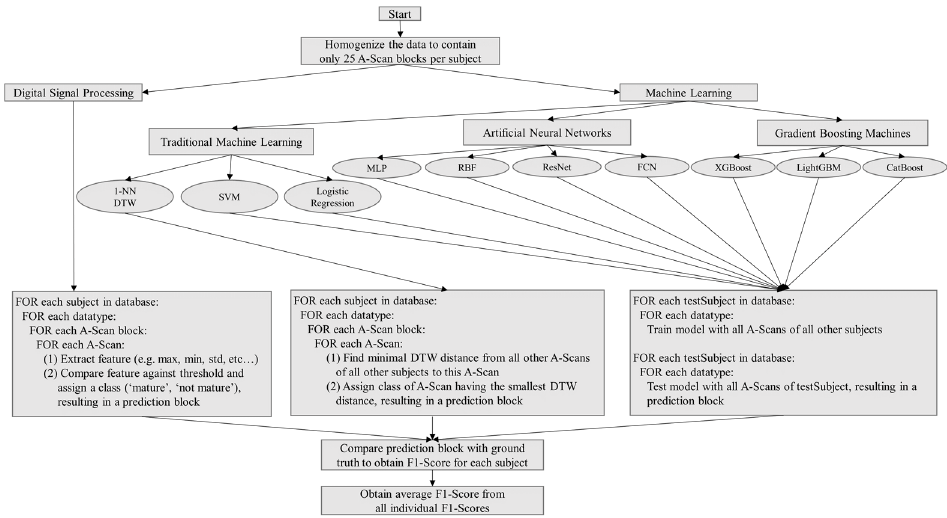
Figure 8. General workflow of the complete data processing